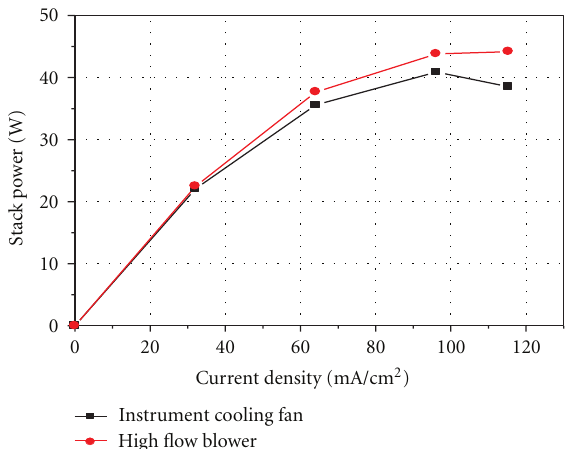
Figure 8: Fuel cell performance due to di ff erent air-moving device.